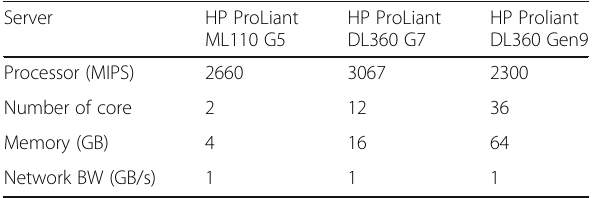
Table 1 Characteristics of servers